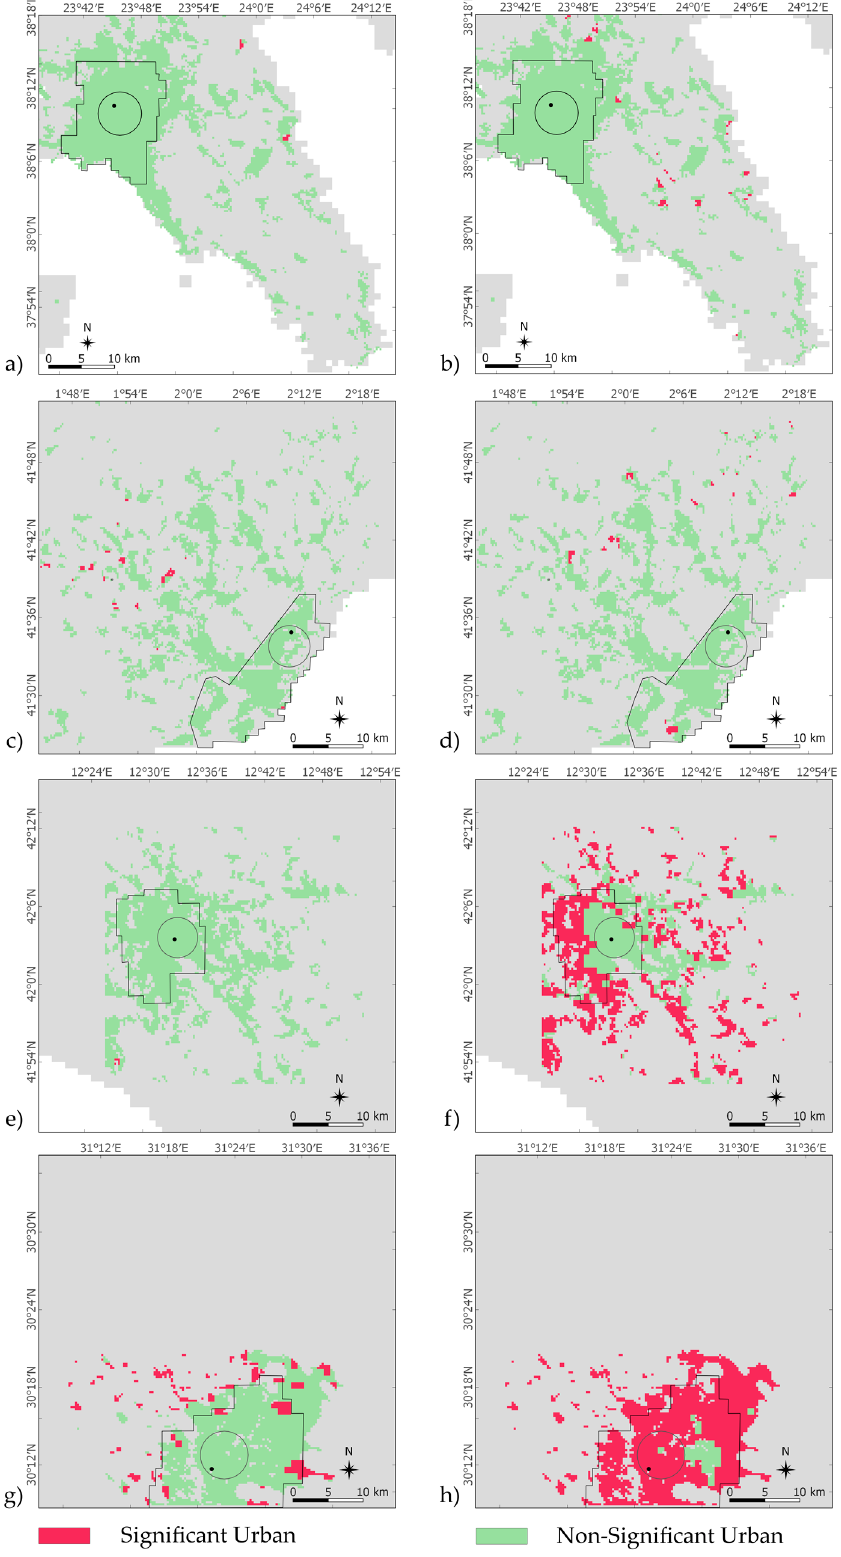
Figure 7. Significant and non-significant urban pixels of ( a ) Athens daytime, ( b ) Athens nighttime, ( c ) Barcelona daytime, ( d ) Barcelona nighttime, ( e ) Rome daytime, ( f ) Rome nighttime, ( g ) Cairo daytime and ( h ) Cairo nighttime. The solid line indicates the boundary of the urban district, the circle indicates the urban core of the city and the point indicates the pixel selected for time series analysis. (gray: outside study area and non-urban pixels, white: sea).